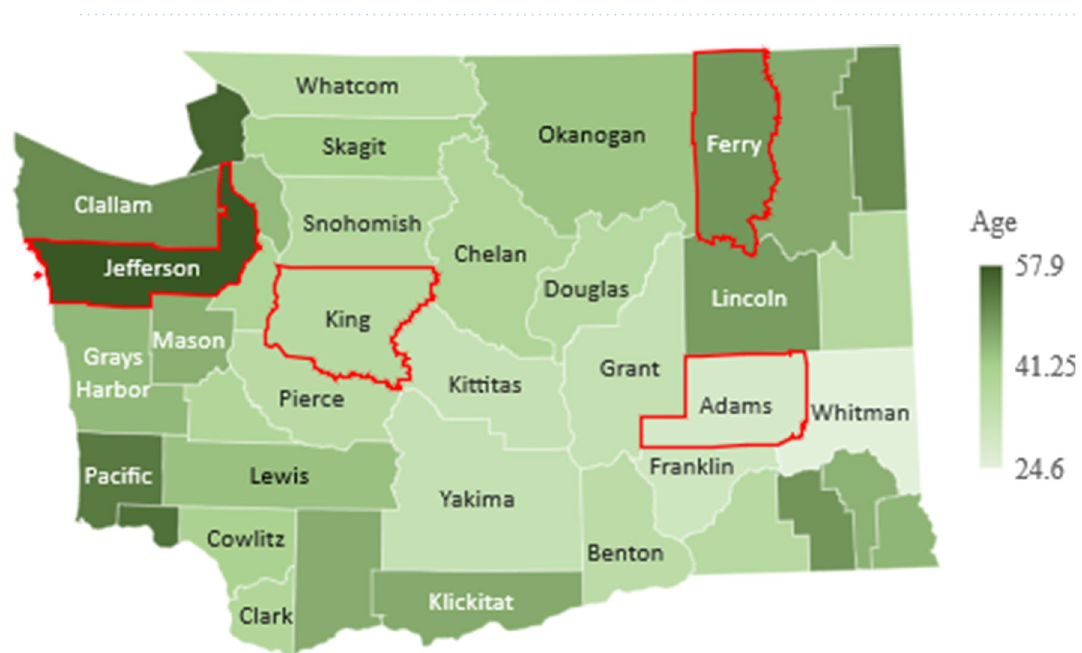
Figure 4. Median age. Figure made with Excel using dataset in 9